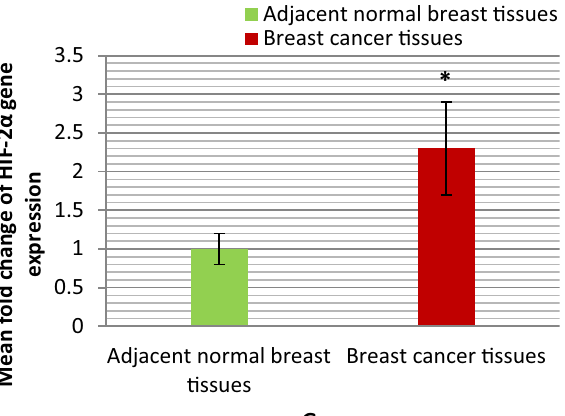
Figure 2. Bar chart representing the mean fold change of HIF-2α gene expression in BC tissues and adjacent normal breast tissues.